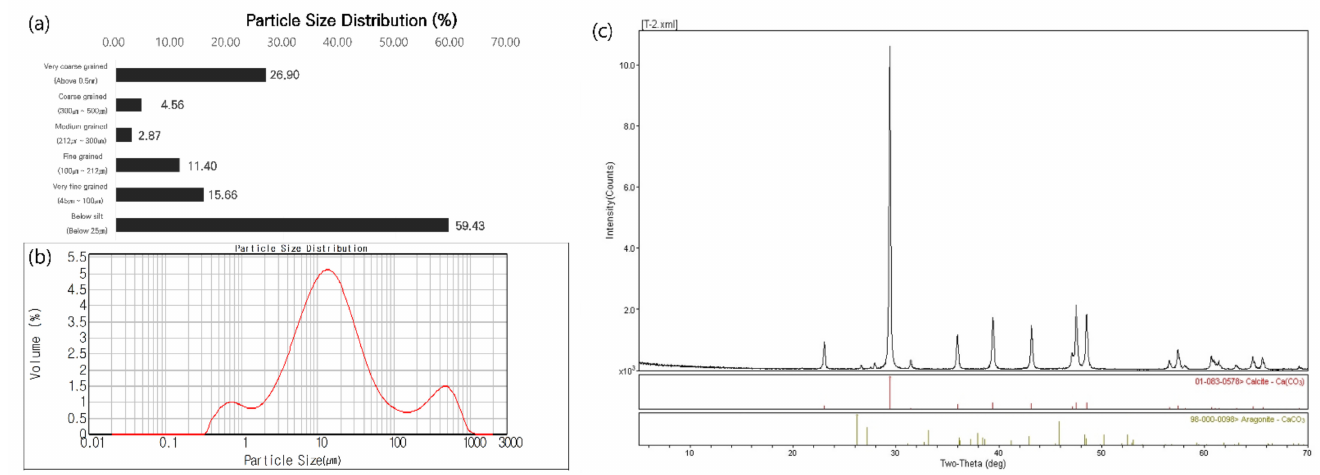
Figure 7. ( a ) Particle size distribution of plaster sieved using standard stainless sieves. ( b ) Graph of